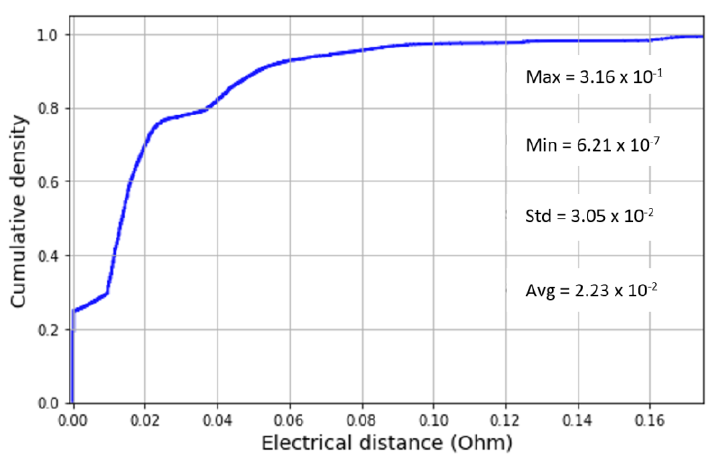
Figure 4. Cumulative distribution function of electrical distances within the test feeder.